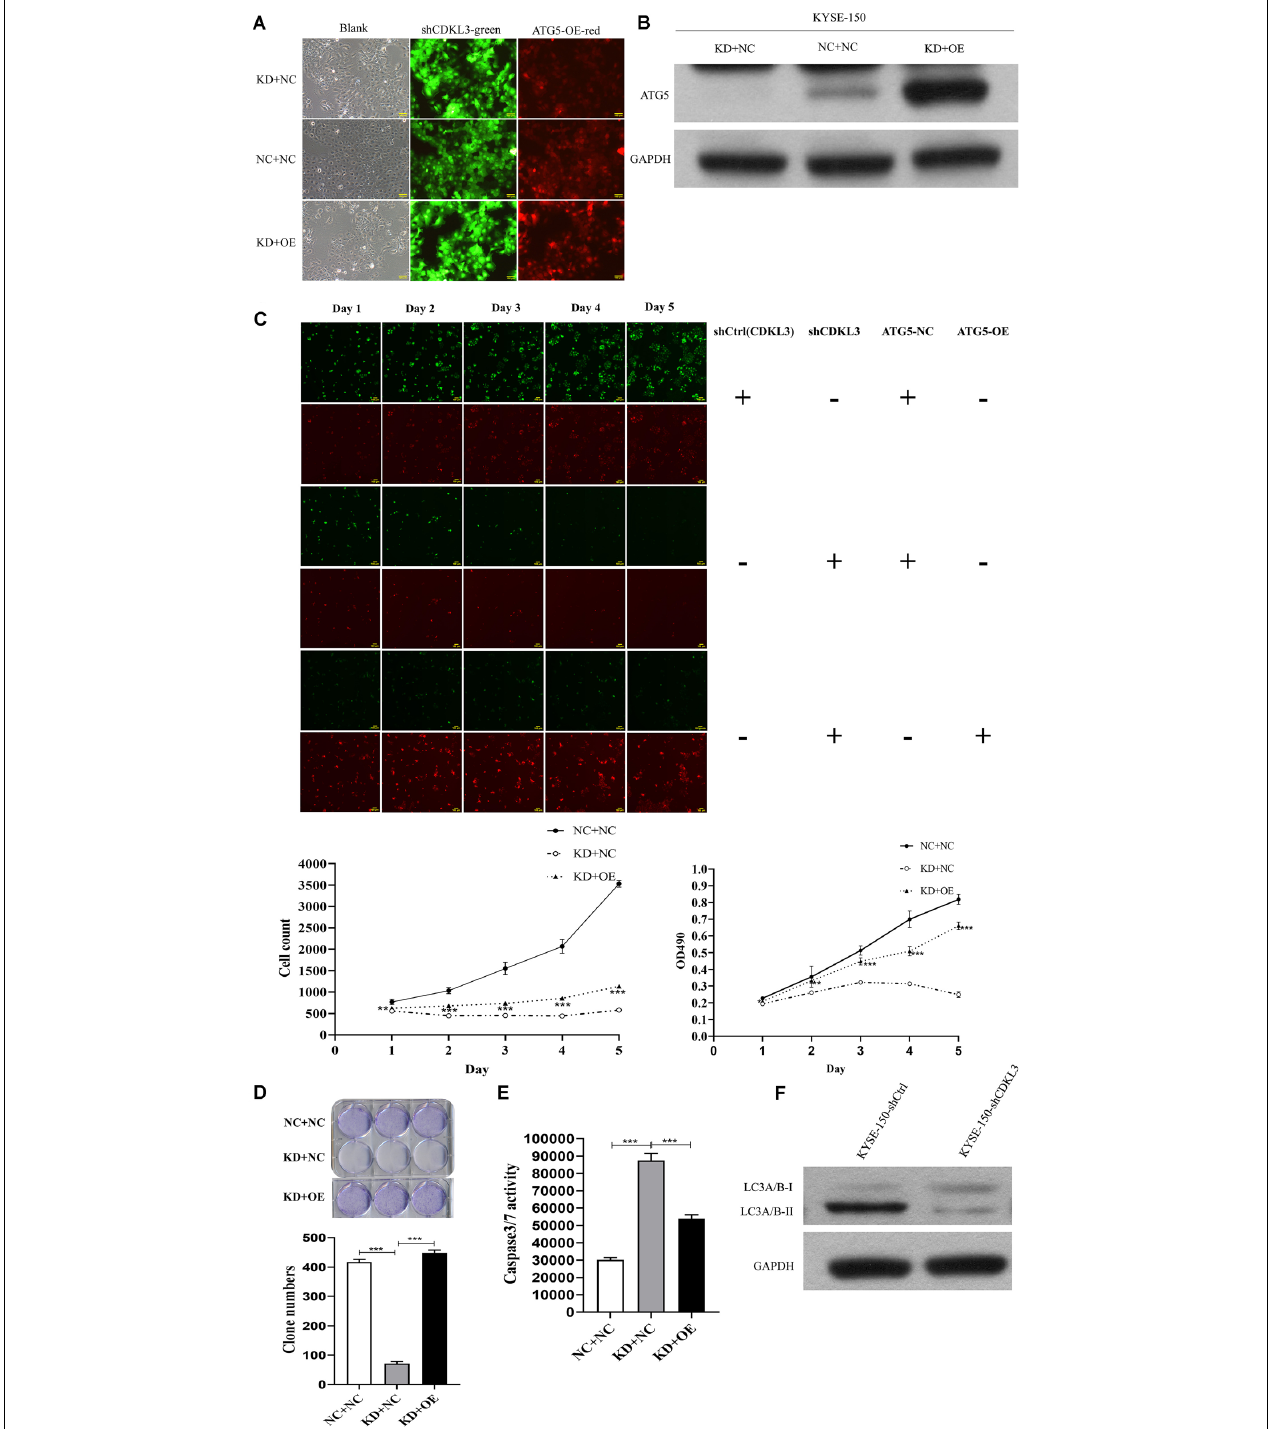
FIGURE 6 | ATG5 re-expression partly counteracted the anti-tumor effect of CDKL3 knockdown in KYSE-150 cells. (A) After infection, KYSE-150 cells expressed green and red fluorescence, Magnification 100 × . (B) Protein level showed that the re-overexpression of ATG5 in KD + OE group and down-expression of ATG5 in KD + NC-2 group (KD + NC). (C) Overexpressed ATG5 partially diminished the anti-tumor effect of CDKL3 knockdown by proliferation assays compared to KD + NC group. (D) The ability of colony formation was restored by ATG5 re-expression compared to KD + NC group. (E) ATG5 re-expression induced caspase-3/7 activity, which was inhibited by CDKL3 knockdown compared to KD + NC group. Data were represented as the mean ± SD of three separate experiments. * P < 0.05; ** P < 0.01, *** P < 0.001. (F) The expression of LC3A/B was analyzed by western blot analysis.